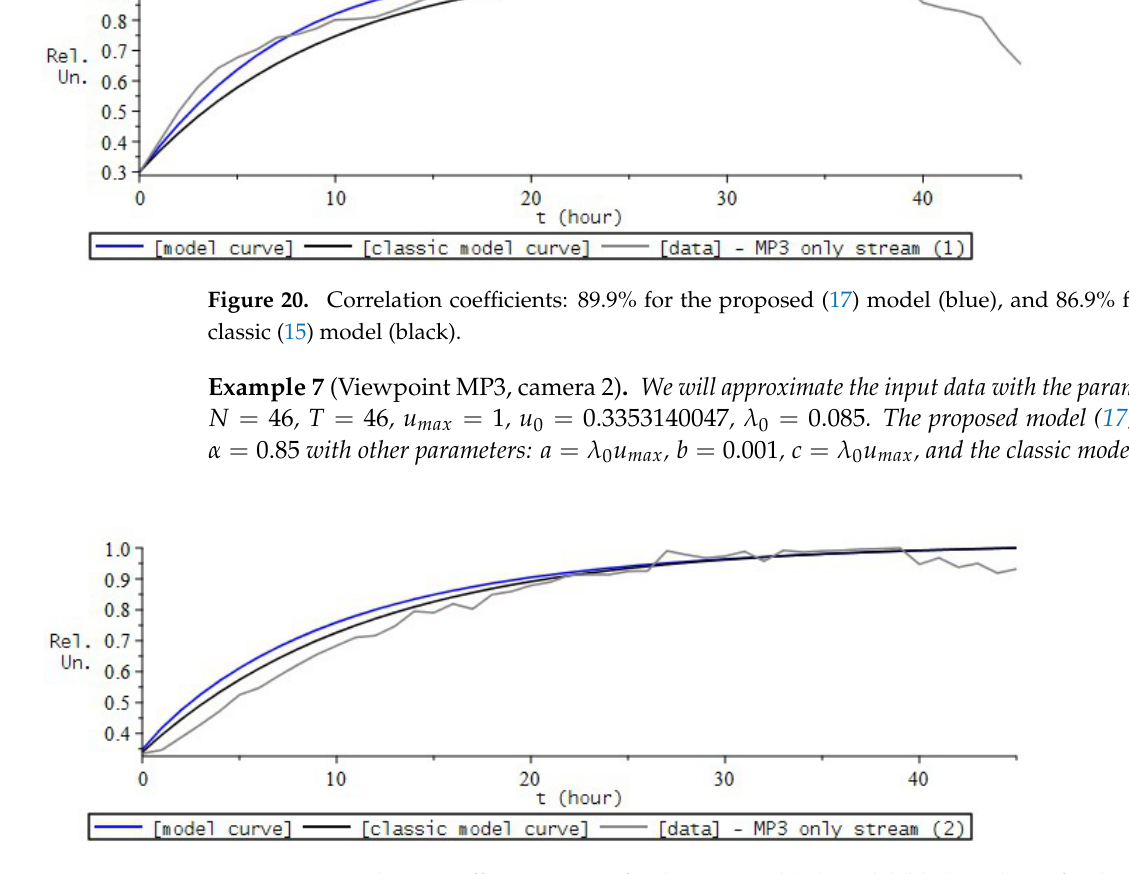
Figure 21. Correlation coefficients: 98.6% for the proposed (17) model (blue), and 99% for the classic (15) model